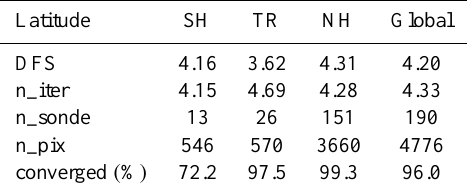
Table 4. GOME validation statistics. DFS represents degrees of freedom, n_iter the number of iterations, n_sonde the number of sondes, n_pix the total number of retrieved pixels, and % the per- centage of converged retrievals. SH stands for Southern Hemisphere ( − 90 to − 30 ◦ ), TR tropics ( − 30 to 30 ◦ ), and NH Northern Hemi- sphere (30 to 90 ◦